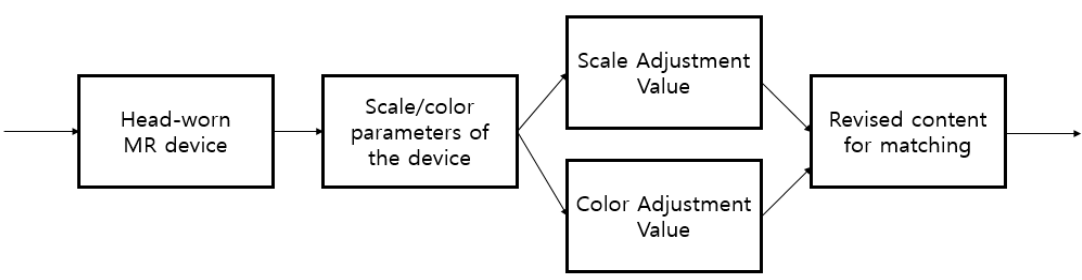
Figure 16. Results regarding color perception. The subjects overestimated the colors when using two MR devices (video and optical).